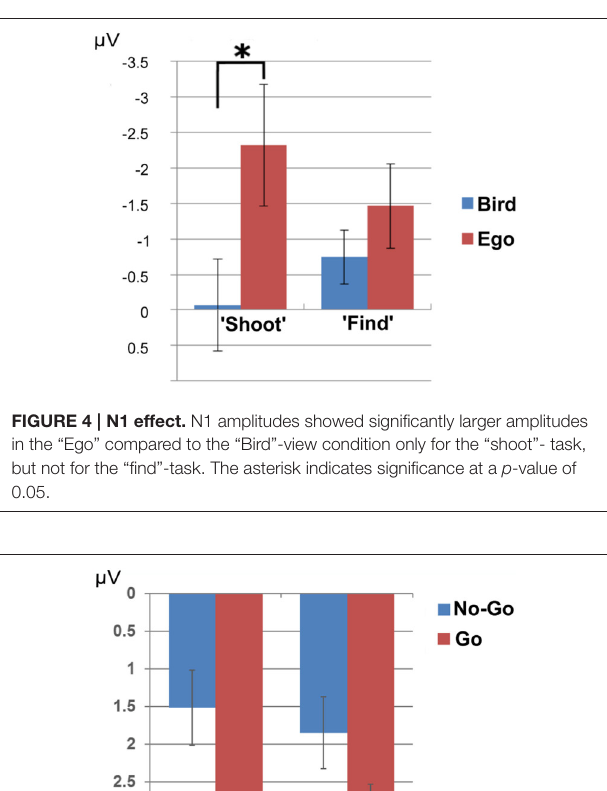
“No-go”—“Go” (target friend—soldier respectively) in the “ego” perspective [ t (29) = − 5.68, p < 0.001, partial eta squared = 0.527] being more pronounced than in the “bird” view [ t (29) = − 4.08, p < 0.001, partial eta squared = 0.364]. This indicates